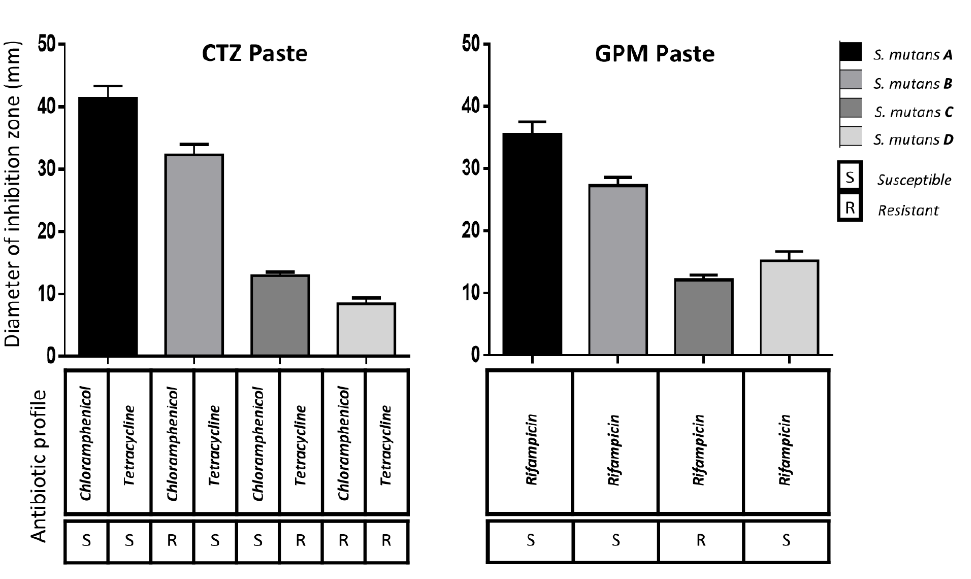
Figure 2. Average and standard deviation of the inhibition zones on the five different E. faecalis strains with the use of CTZ and GPM pastes. Under the bars, the specific antibiotic profile of each strain is shown. The comparisons with no differences ( p > 0.05) were the strains A vs. B and B vs. C when CTZ paste was used, and the strains B vs. C when GPM paste was used. Two-way ANOVA and post hoc Tukey – Kramer multiple comparisons test were applied. 4. Discussion There are different techniques and protocols for pulp treatment in primary teeth, which depend on the extent of the damage and the pathological compromise [18,19]. En- dodontic principles recommend absolute isolation, odontometry, chemical – mechanical cleaning, and filling to eradicate bacteria when a pulpectomy is performed. However, sev- eral complications could occur during the treatment. These complications have led clini- cians to propose simplified techniques [20] based on AFP use, including antibiotic prepa- rations. Antibiotic resistance has become a widespread menace that requires attention and intervention. It is of the utmost importance, because it limits the therapeutic options for